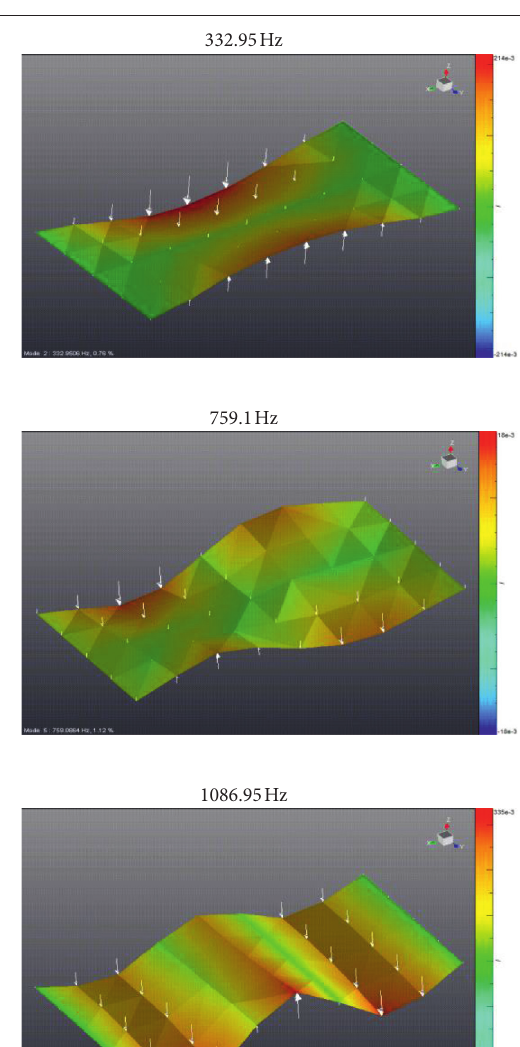
Table 5: Experimental modal analysis: mode shapes and natural frequencies (Case